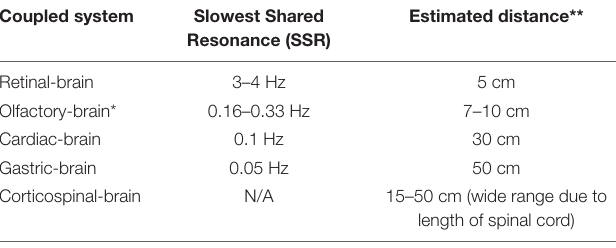
TABLE 1 | Slowest Shared Resonance (SSR) between coupled neural